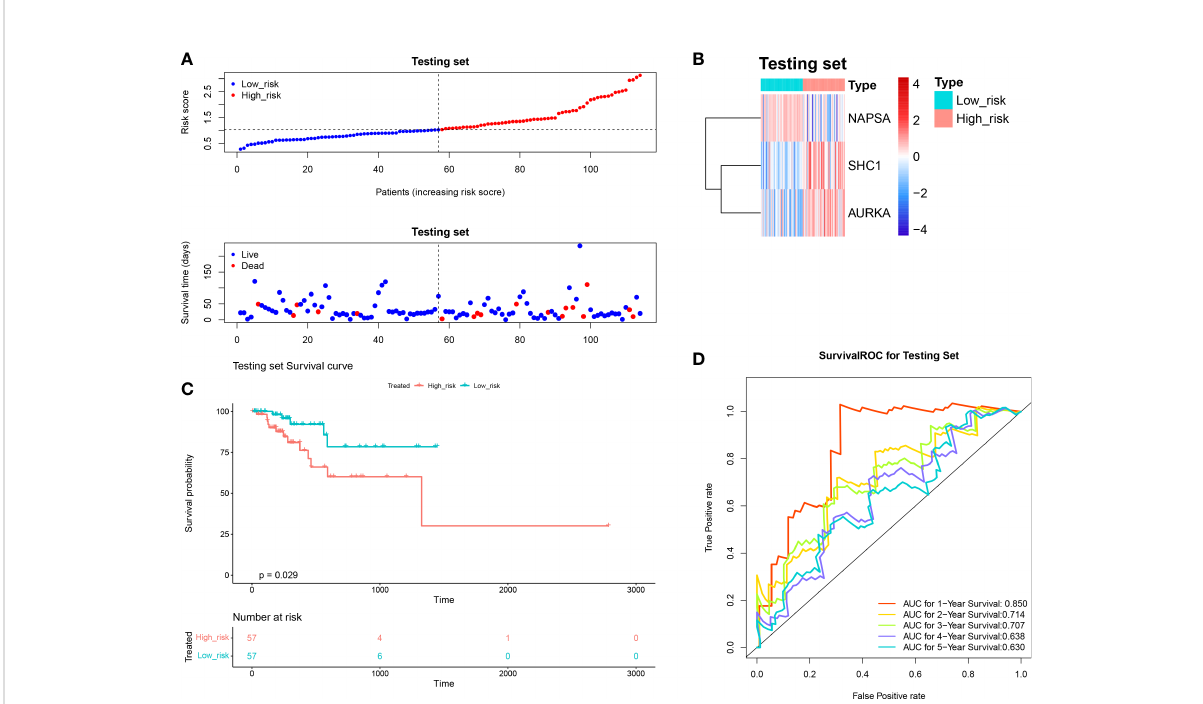
FIGURE 5 Validation of the autophagy-related risk score model (in the internal TCGA). (A) The test set high and low-risk group curves. (B) Heat map of model gene expression in the high and low-risk groups of the test set. (C) The test set high and low-risk group KM survival curves. (D) Test Set Survival ROC